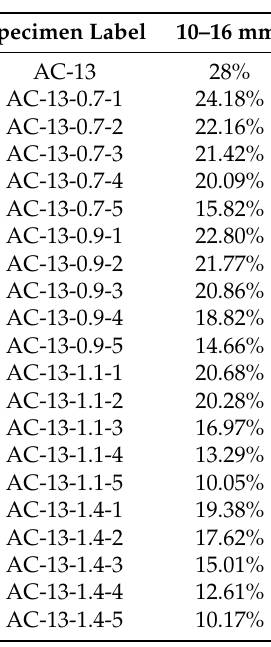
Table 3. Sieving result of ground asphalt